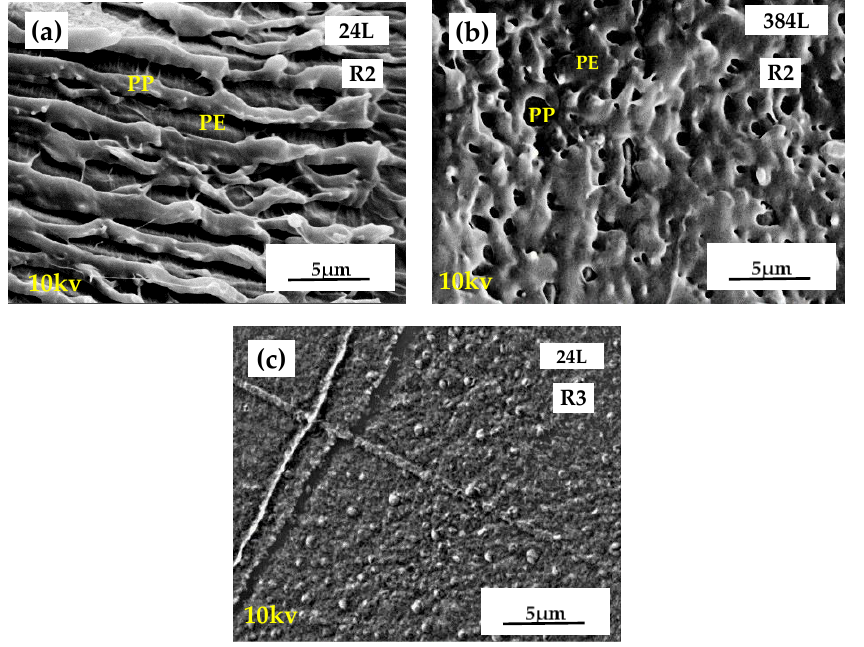
Figure 5. SEM micrographs of ( a ) the PP/LLDPE/PP-24L and ( b ) the PP/LLDPE/PP-384L films recycled with the R2 recycling process, and ( c ) the PP/LLDPE/PP-24L film recycled with R3.